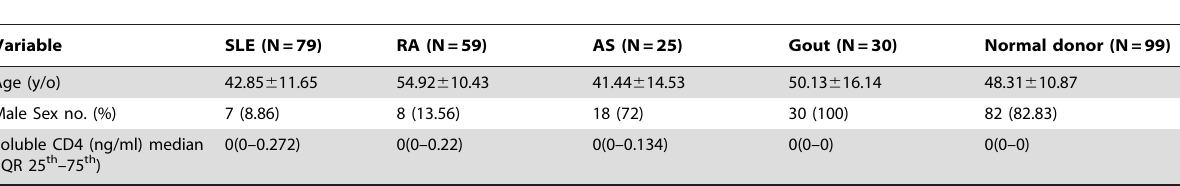
Table 1. Clinical characteristics and sCD4 levels of normal donors and subjects with SLE, RA, AS and gout.